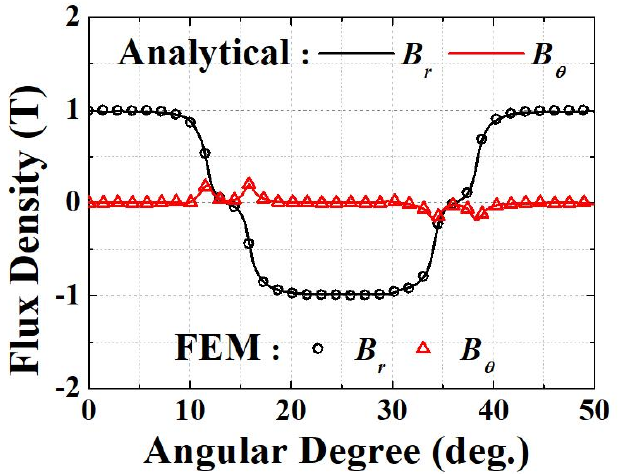
Figure 8. Comparison of magnetic field characteristics considering both open circuit and armature reaction.